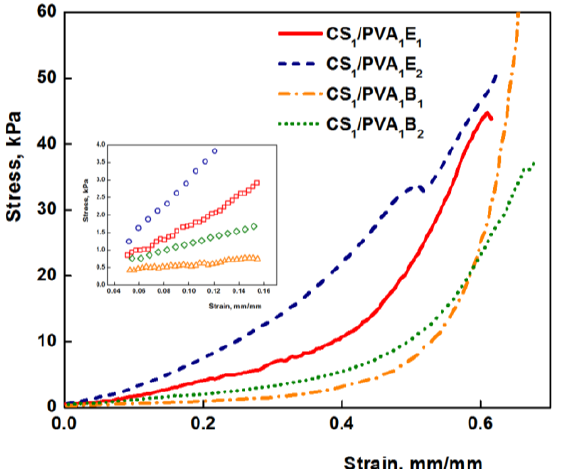
Figure 5. Stress–strain curve for CS/PVA hydrogel under compressive loading ( t T = 24 h). In detail the linear range for determining the elastic modulus is represented.